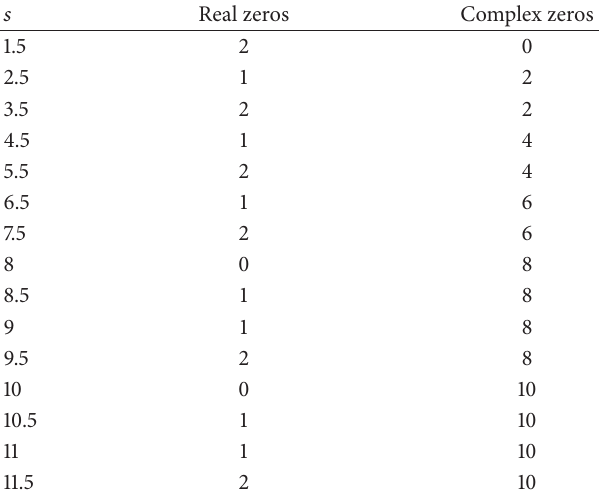
Table 1: Numbers of real and complex zeros of 𝐸 (ℎ) 𝑞 (𝑠,𝑤)